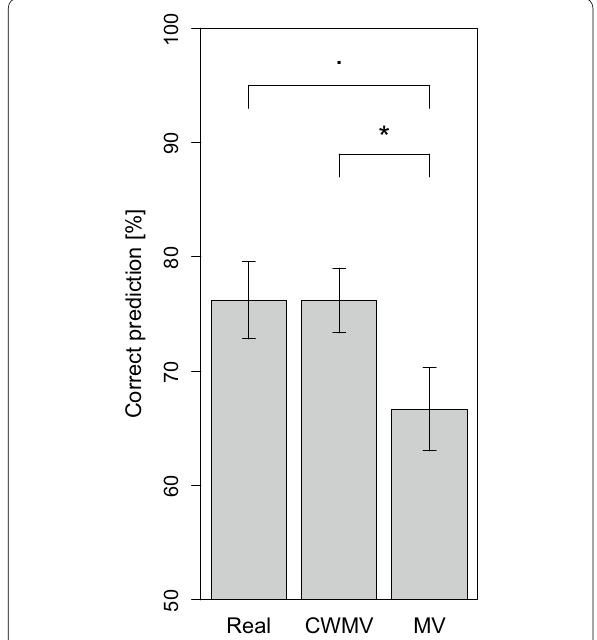
Fig. 2 Performance of real versus simulated groups. Comparing the accuracy of real group decisions to simulated group decisions using either CWMV or MV for aggregation of the individual decisions and confidences. Simulated groups based on CWMV predict the performance of real groups very well, while simulated groups based on MV underestimate the performance of real groups. Error bars indicate standard errors of the mean computed across groups. ∗ p < 0.05 . · p < 0.1